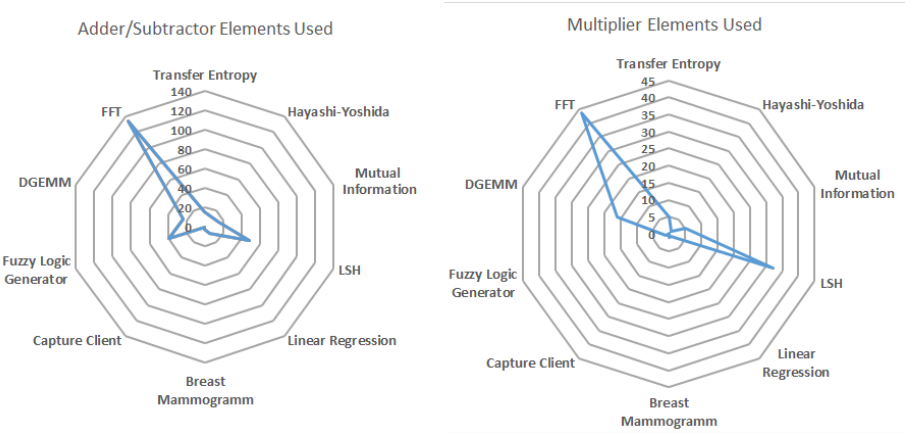
Figure 1. Spider graphs reporting the number of adder/subtractor and multiplier elements used in the 10 sample